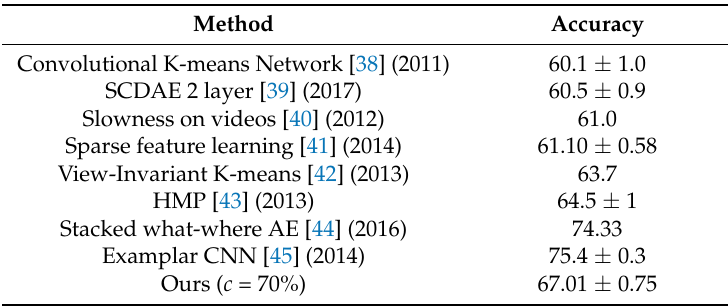
Table 2. Comparison of test accuracy mean ± std% on all folds of